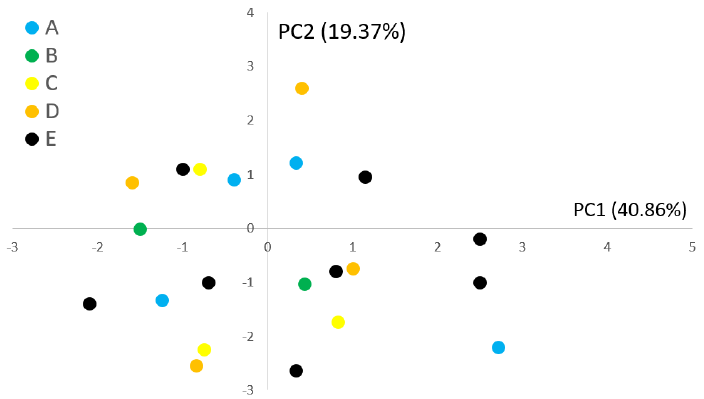
Figure 8. Plots created using the values of the first two principal components obtained by PCA ordination of the physico-chemical data reported in Table 1 and surveyed in the 21 monitored coastal ponds grouped as indicated in Figure 1: A, pastures; B, agricultural with grasses; C, reserves; D, urban; E, mixed agricultural and